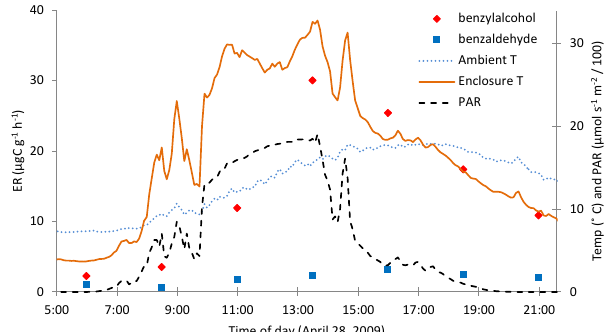
Fig. 3. Profile of benzyl alcohol and benzaldehyde emissions from crabapple for a day of measurements at full bloom with temperature inside the enclosure, ambient temperature and photosynthetically active radiation (PAR).